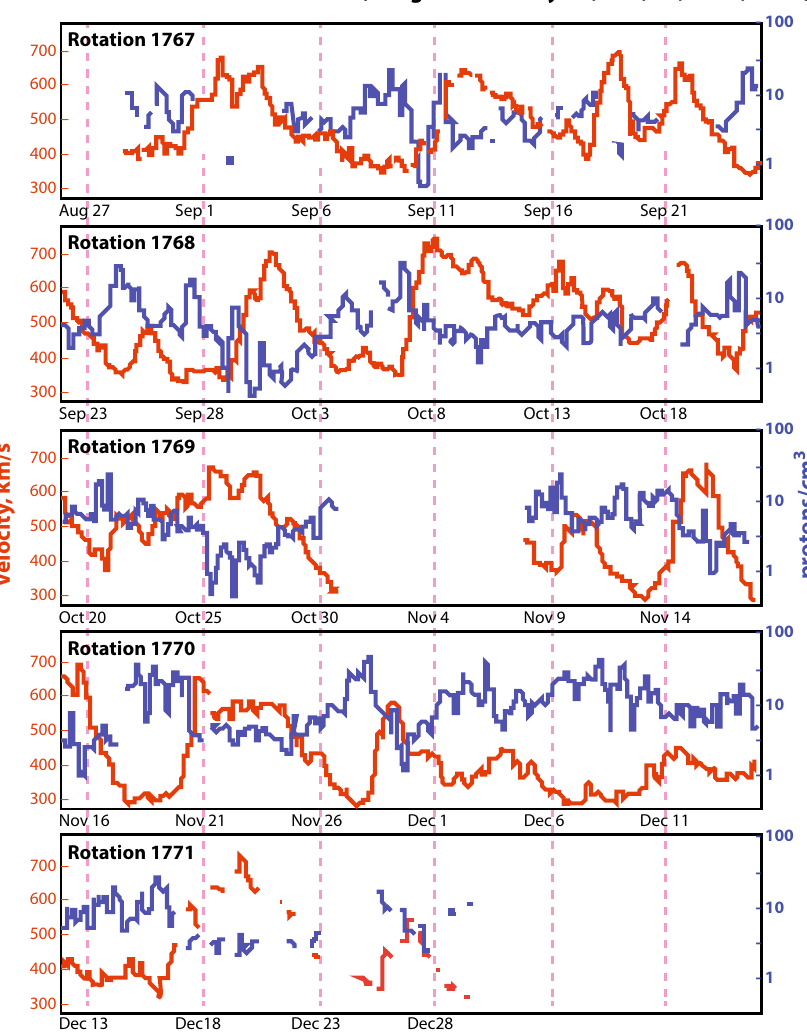
Fig. 6 Mariner-2 observations of the continuous solar wind. Image reproduced with permission from Neugebauer and Snyder (1966), copyright by AGU